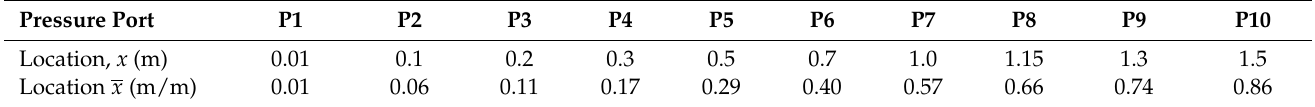
Table 1. Location of pressure ports with distances measured from the